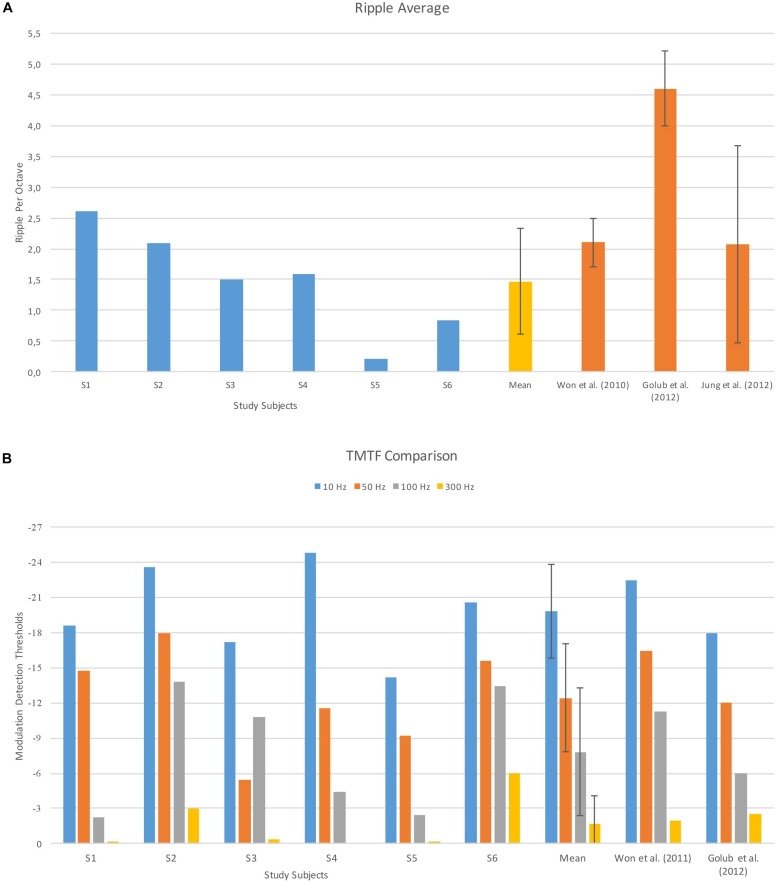
Spectral ripple discrimination (A) and TMTF (B) performance of study subjects and mean scores from previous studies. Error bars indicate ±1 standard deviation. Data adopted from Won et al. (2010), Golub et al. (2012), and Jung et al. (2012).